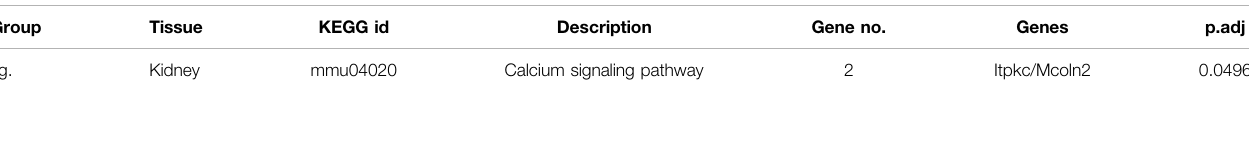
TABLE 5 | Information of the enriched KEGG